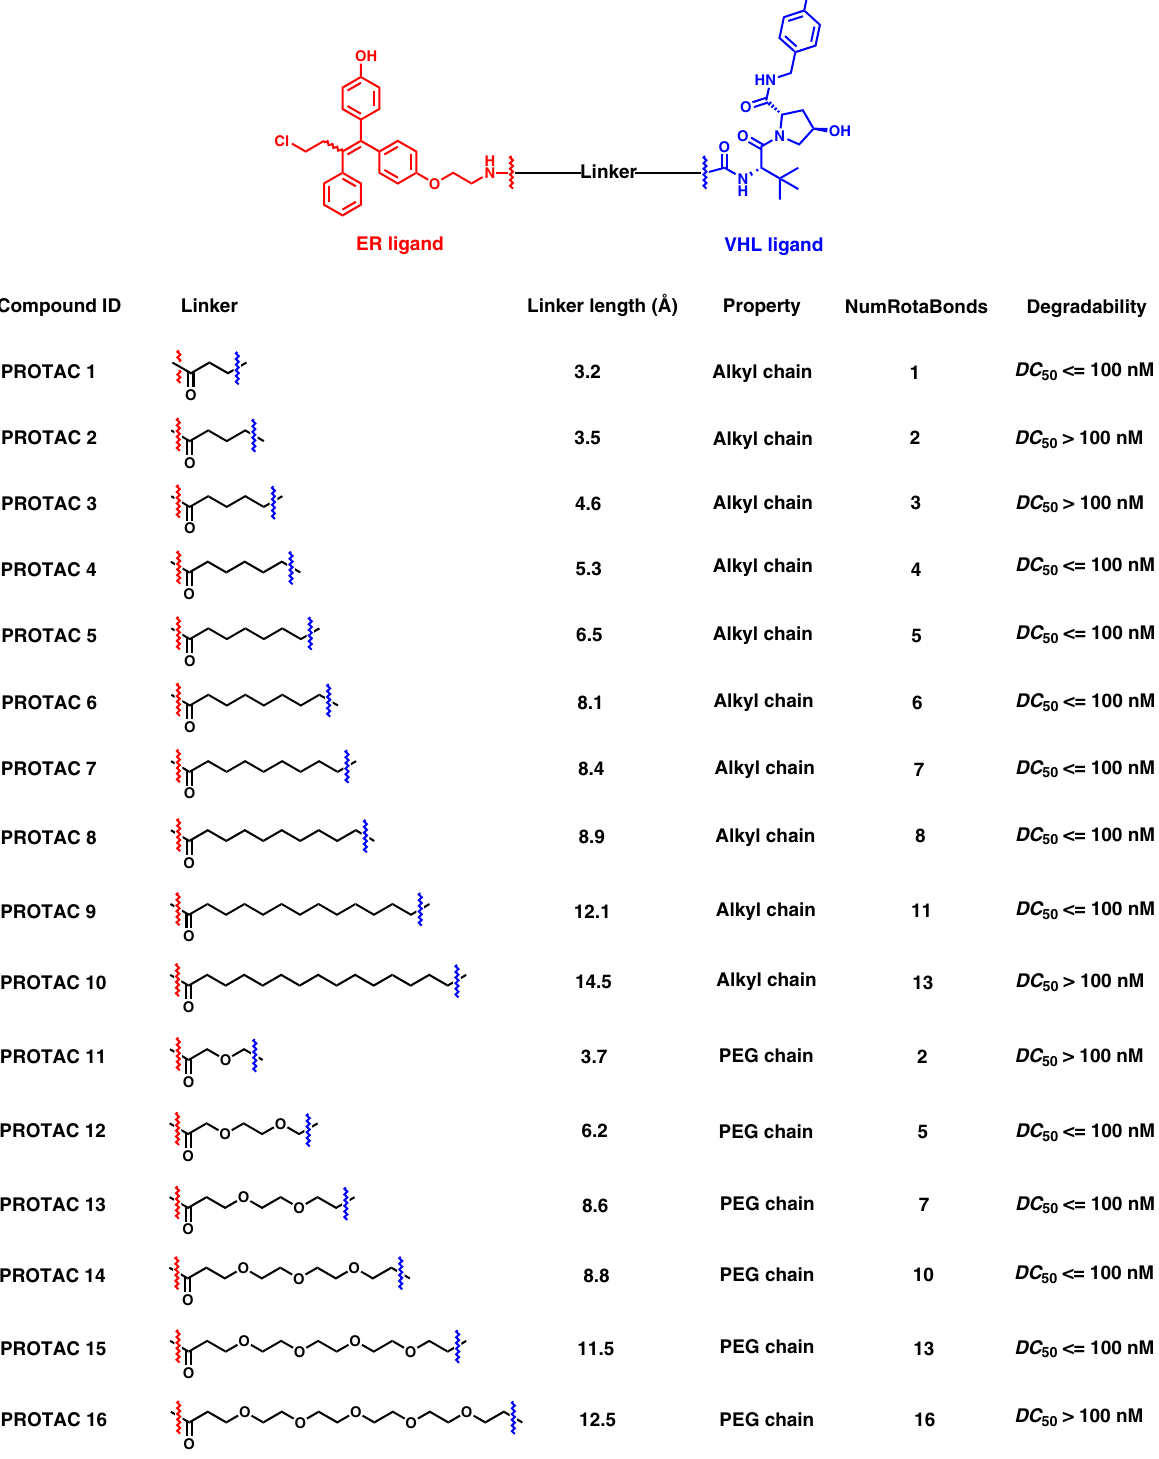
Fig.5|Chemicalstructuresandpropertiesof16PROTACsinourexperimentaldataset. PROTAC1 – 10arebuiltwithlinkersofalkylchain,whilePROTAC11 – 16arebuilt with linkers of PEG